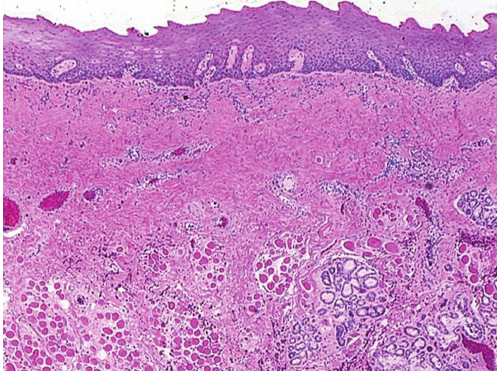
Figure 2: Low magnification H&E stained histopathological slide showing dense fibrosis of the stroma with infiltration to the skeletal muscular layer and minor salivary